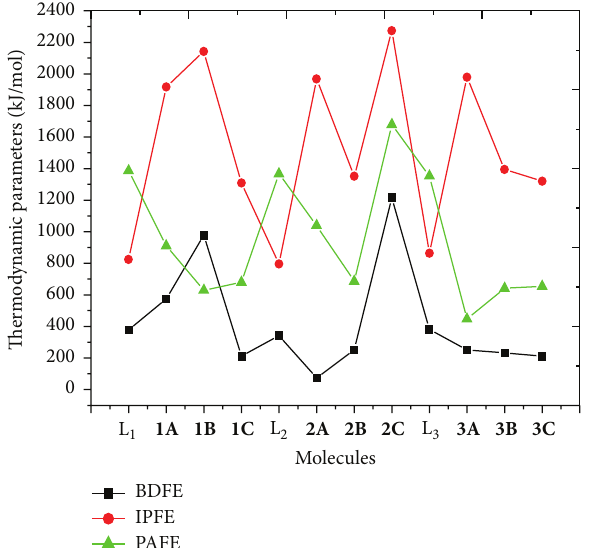
Figure 2: Superposition of BDFE, IPFE, and PAFE of juglone, its derivatives, and their